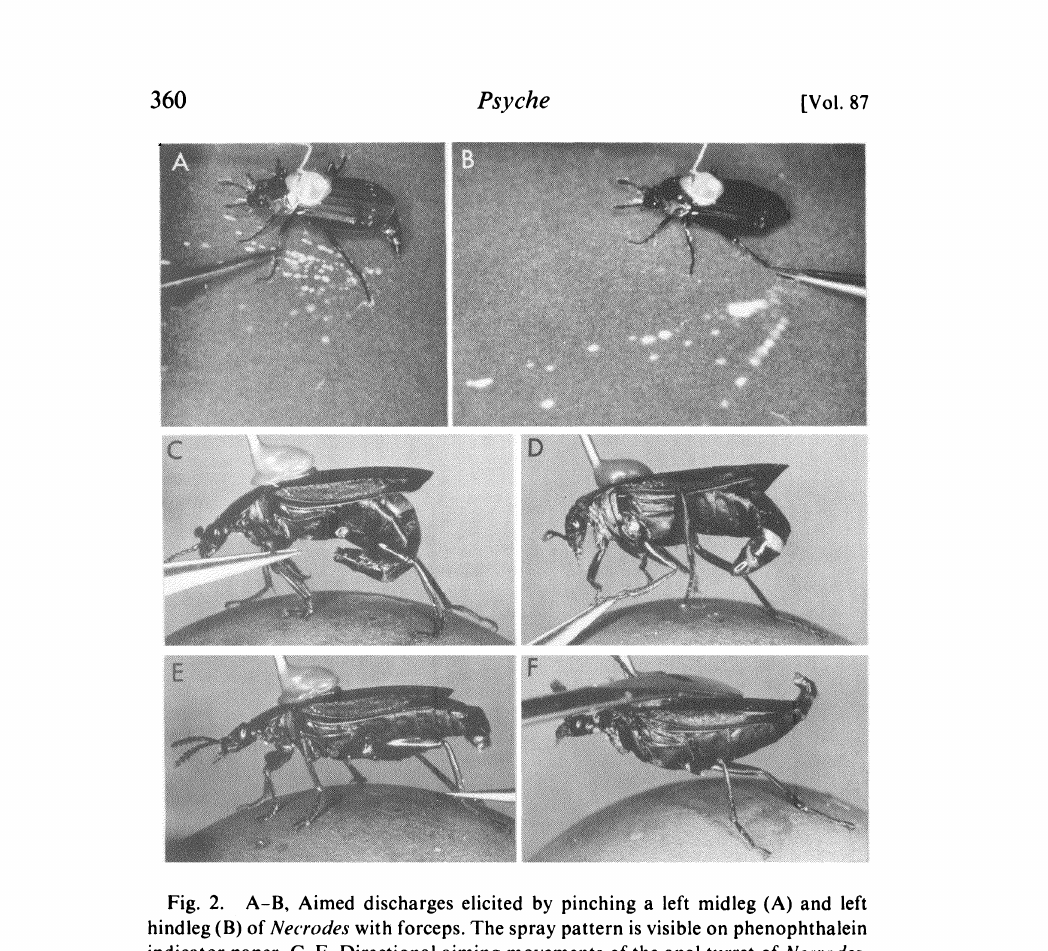
Fig. 2. A-B, Aimed discharges elicited by pinching a left midleg (A) and left hindleg (B) of Necrodes with forceps. The spray pattern is visible on phenophthalein indicator paper. C-F, Directional aiming movements of the anal turret of Necrodes. Note that the abdominal tip is accurately pointed toward the site of application of the stimulus: (C) tibia of midleg, (D) tarsus of midleg, (E) tibia of hindleg, pinched with forceps; (F) back of beetle touched with hot